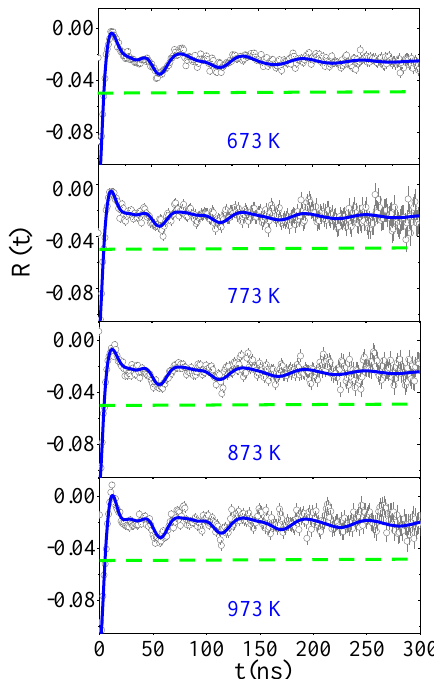
Figure 1. Time-di ff erential perturbed gamma–gamma angular correlations (TDPAC) spectra measured at room temperature (RT) as a function of the annealing temperature for SnO 2 powder samples. The continuous blue curves are the fit of theoretical model based on Equation (1) to experimental data represented by the open circles with error bars. The green dashed horizontal lines are guides to the eye for R(t)= −0.05. The fits followed a two fractions model with probes that interacted given the two main EFG 1 and EFG 2 distributions. The primary distribution, EFG 1 , was extremely damped and accounted for f 1 > 80% of the 111 In/Cd probes. The EFG 1 and EFG 2 increased with annealing temperature. The 1 was higher than 2. The decrease in the EFG distributions indicates that In progressively experienced a more regular local environment at higher annealing temperatures. Variations in the EFG parameters showed an irreversible annealing temperature dependence that suggests this process was due to a cumulative annealing effect. The temperature dependence of the parameters further confirms that the observed R(t) damping was primarily due to the random distribution of the 1.4% Cd atoms in the SnO 2 provided by each 111 In/Cd atom sitting at Sn substitutional sites. These experienced slightly different charge distribution environments, even if stable Cd atoms were several unit cells away from the radioactive species.